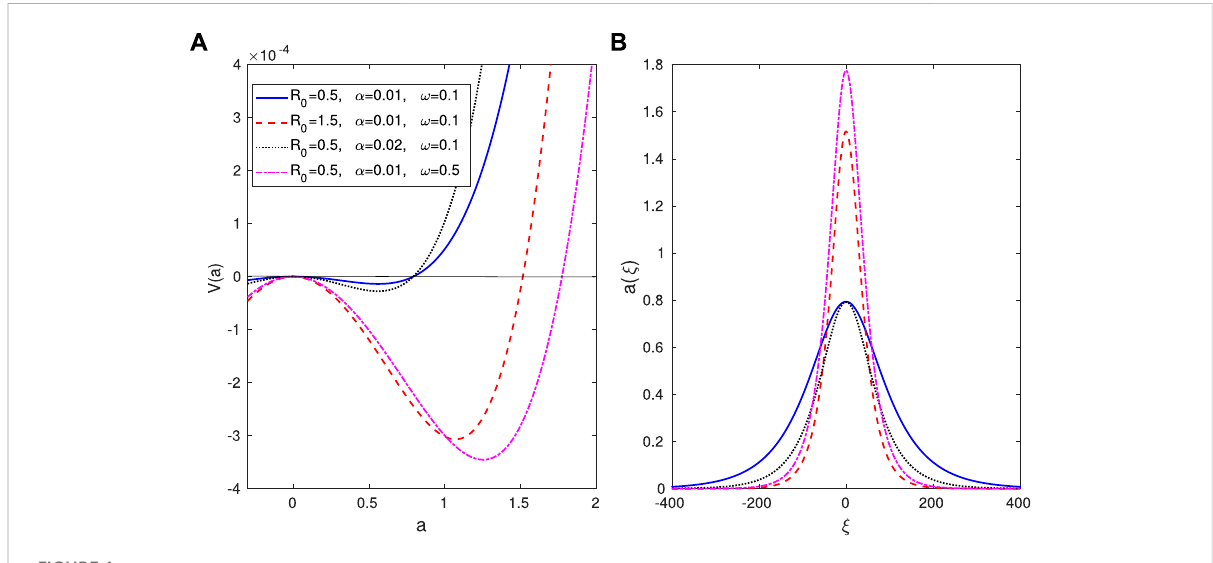
FIGURE 1 The Sagdeev potential V ( a ) [subplot (A) ] and the corresponding soliton solutions a ( ξ ) [subplot (B) ] are shown for different values of the parameters as in the legends with a fi xed value of k 0 =